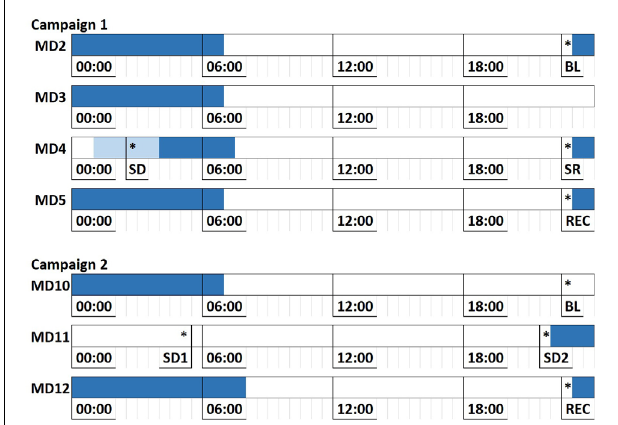
FIGURE 1 | Sleep deprivation/restriction implementation across HERA campaigns 1 and 2. Each line represents a full mission day, with mission day number denoted to the left. Dark blue areas denote scheduled sleep opportunity. Light blue area in C1 MD4 denotes the range of sleep opportunity times due to variation in sleep schedule across missions in campaign 1. Asterisks denote average time of administration of the Cognition test battery across missions. MD, Mission Day; BL, Baseline; SD (1/2), Sleep Deprivation; SR, Sleep Restriction; REC,